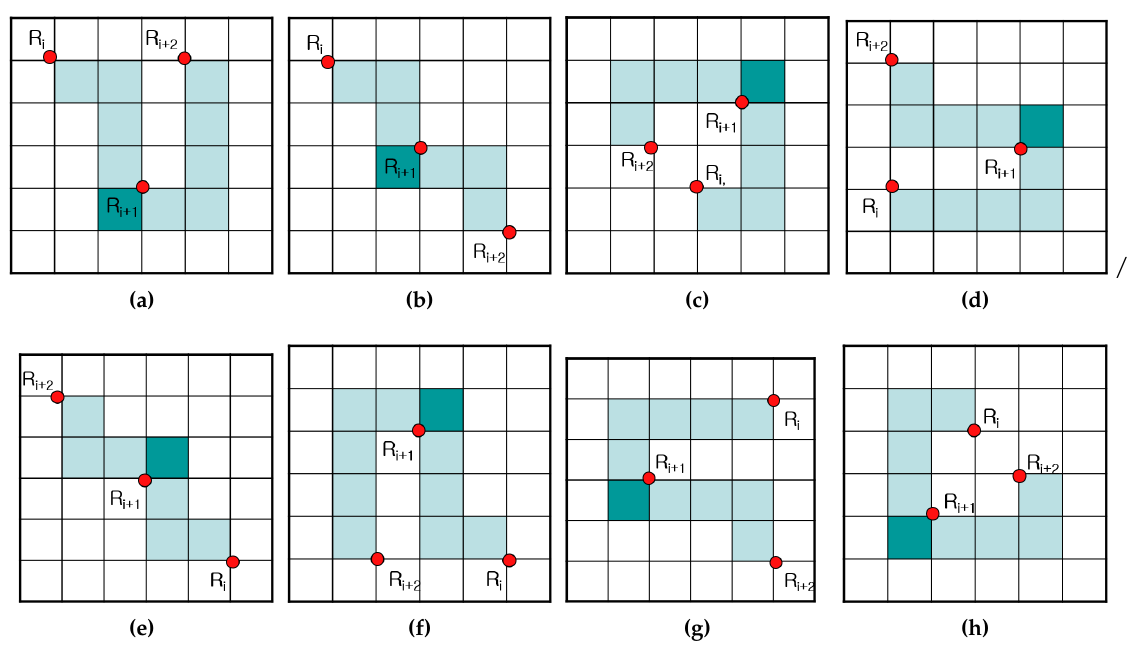
Figure 14. Restoration cases for different sequences of representation points. ( a – h ) Case 1–8.